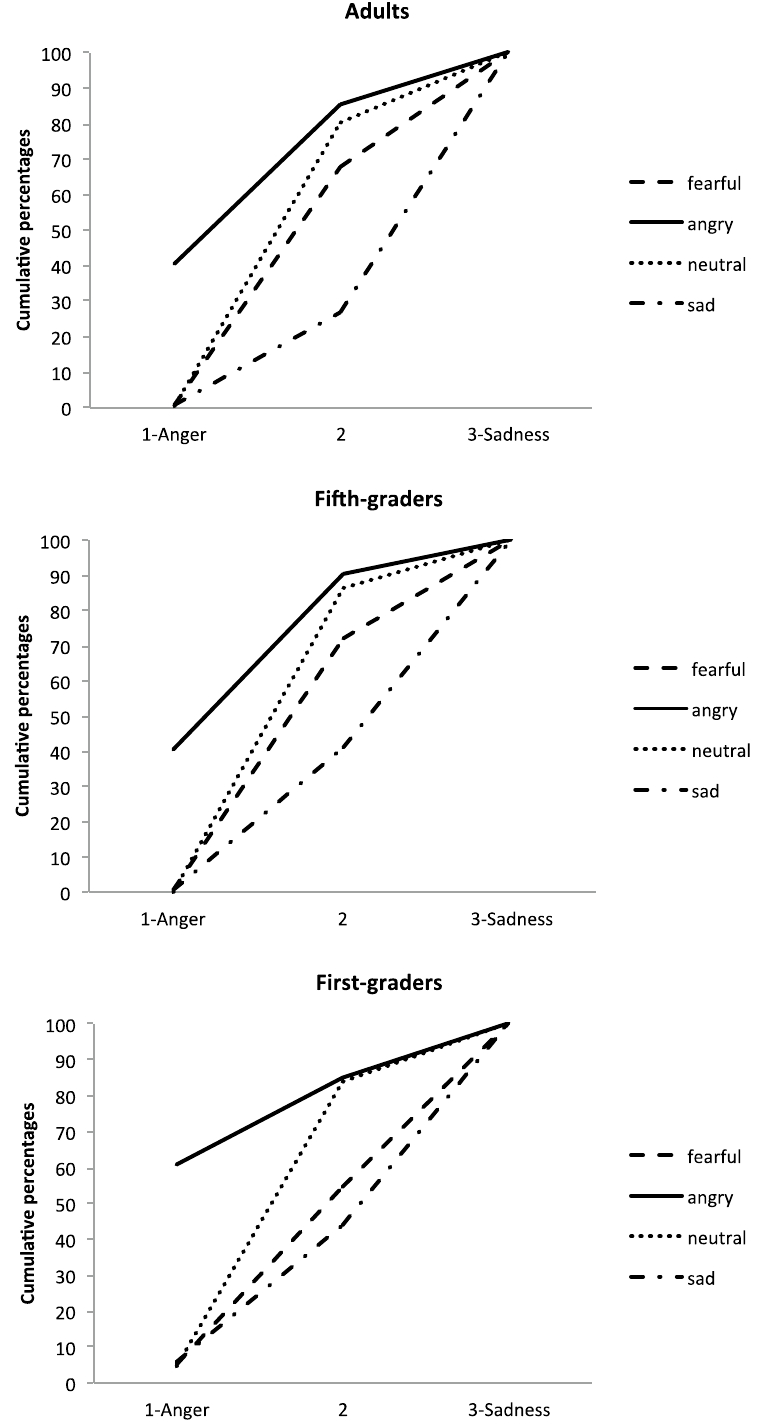
Figure 4. Cumulative percentages of the perception of EFE on Scale 2, for each age